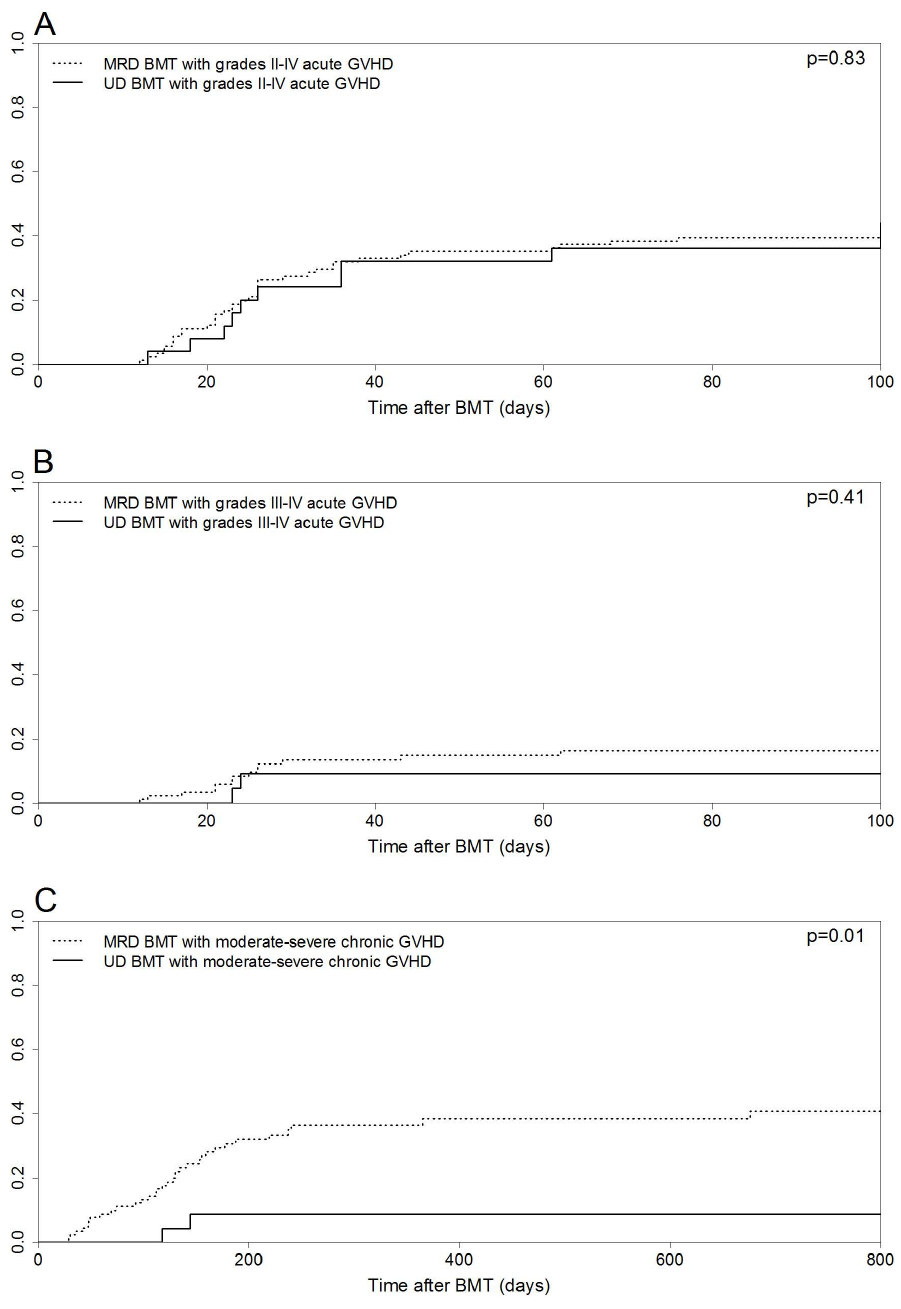
Figure 1. Cumulative incidence curves for matched related donor (MRD) and unrelated donor (UD) bone marrow transplantation (BMT). (A) Cumulative incidences for grades II–IV acute graft-versus-host disease (GVHD). (B) Cumulative incidences for grades III–IV acute GVHD. (C) Cumulative incidences for moderate-severe chronic GVHD.